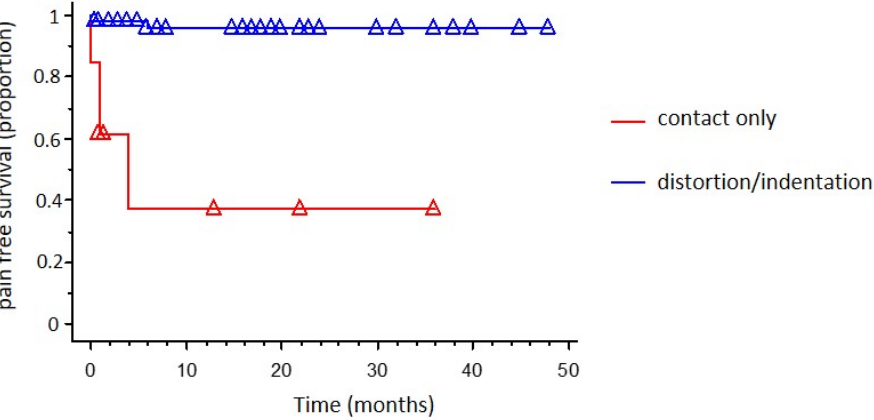
Figure 2. Kaplan–Meier cumulative probability of pain-free survival in patients submitted to MVD, stratified by kind of neurovascular conflict.